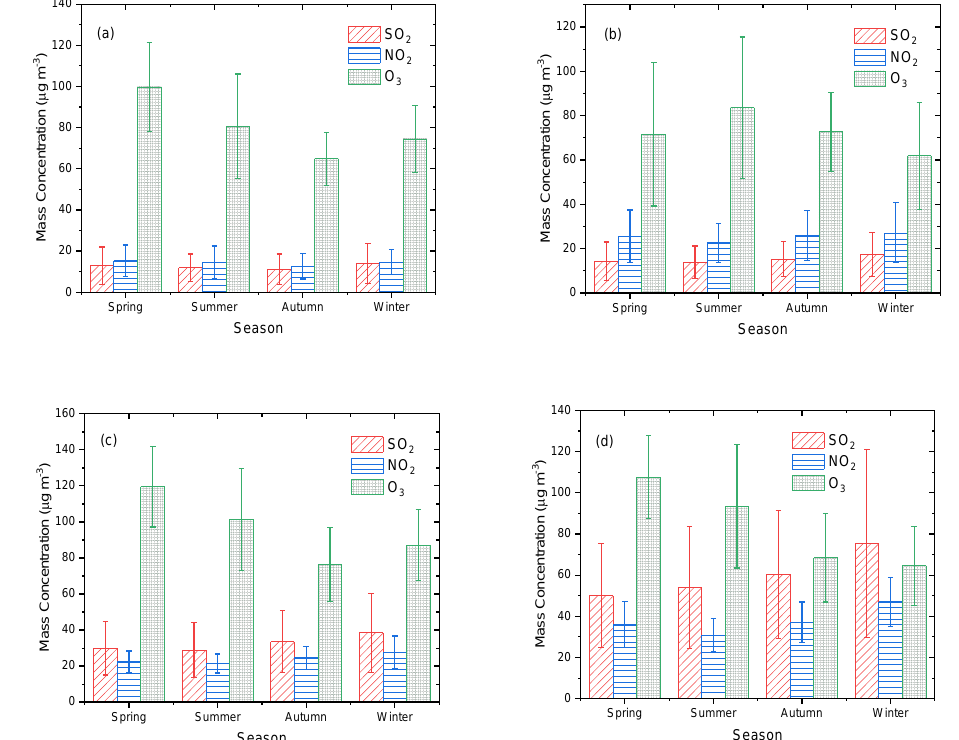
Figure 10. Seasonal mean mass concentrations of SO 2 , NO 2 , and O 3 in ( a ) Aba, ( b ) Ganzi, ( c ) Liangshan, and ( d ) Panzhihua.